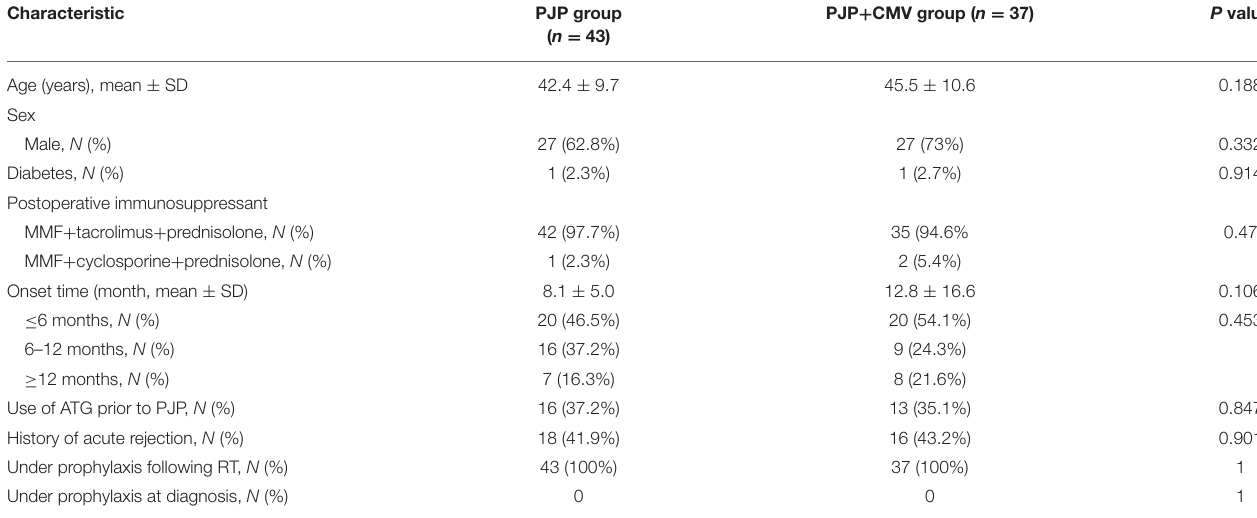
TABLE 1 | Comparison of demographic characteristics between the PJP and PJP + CMV groups.